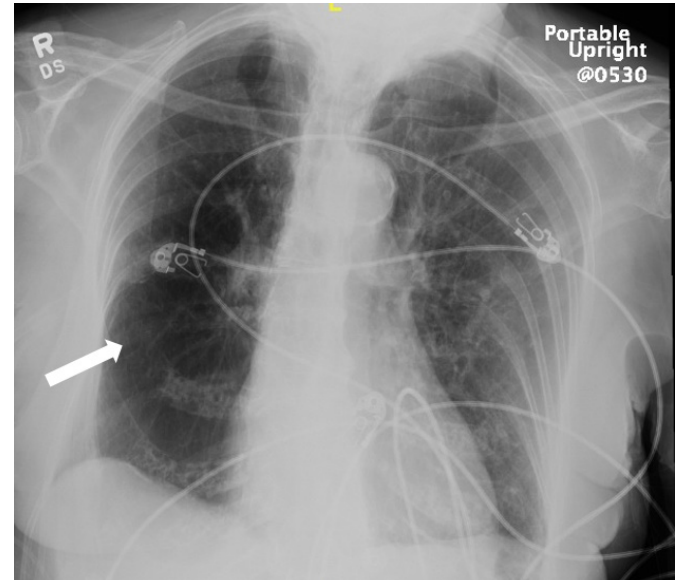
Image 1. Chest radiograph. Image is notable for increased lucency within the right hemithorax